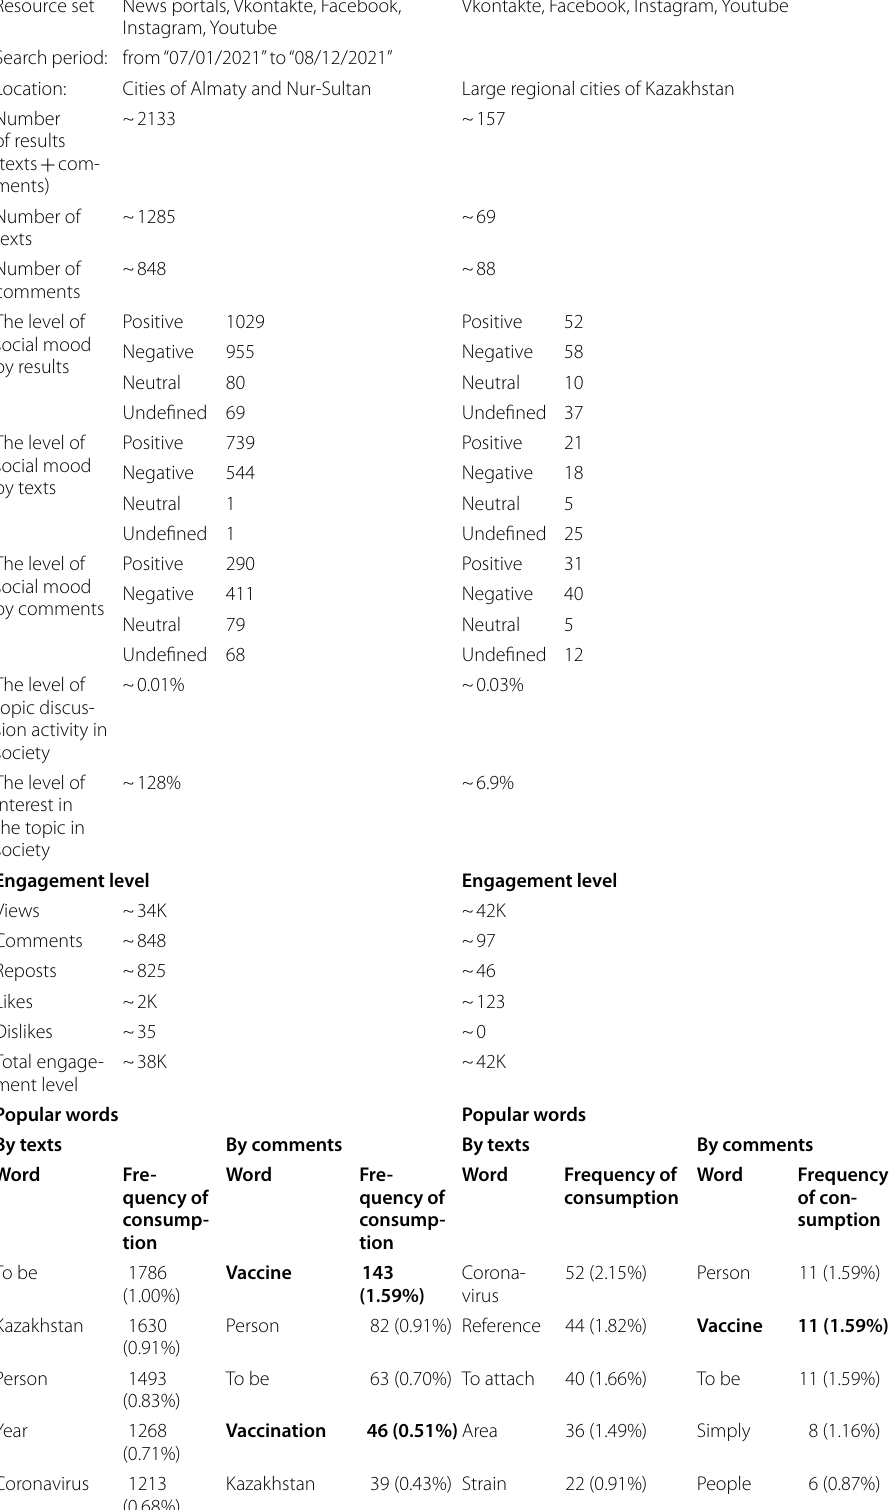
Table 14 Analysis by topics for period 2 Resource set